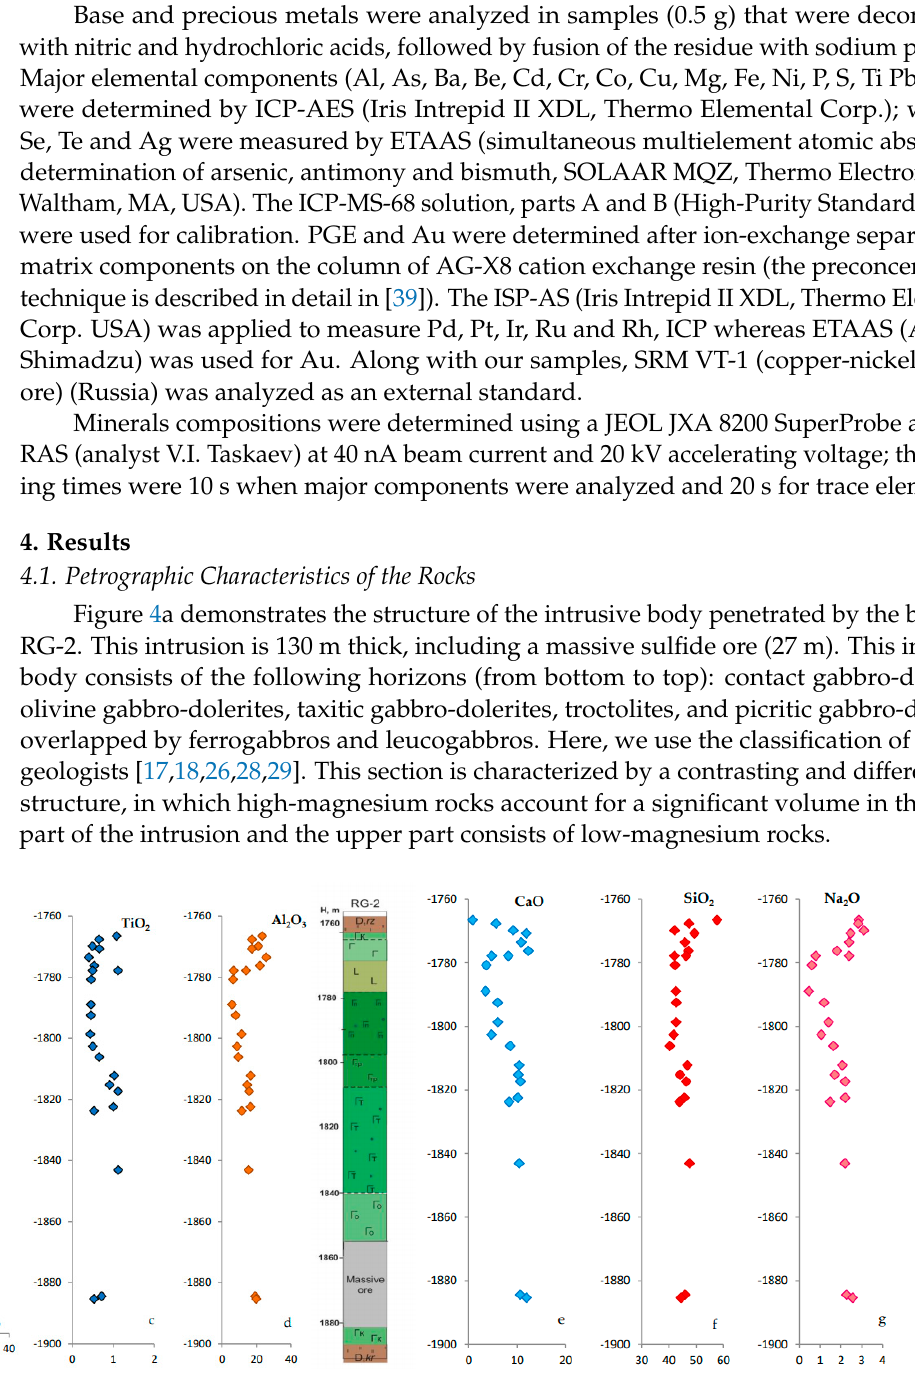
Figure 4. Inner structure of the intrusion ( a ) and distribution (wt.%) MgO ( b ), TiO 2 ( c ), Al 2 O 3 ( d ), CaO ( e ), SiO 2 ( f ) and Na 2 O ( g ) in its vertical section (borehole RG-2). Captions to Figure 4, gabbro-dolerites: Гк —contact, Го —olivine-bearing, Гт —taxtic, Гп —picritic, Г —olivine-free, L—leucogabbro.